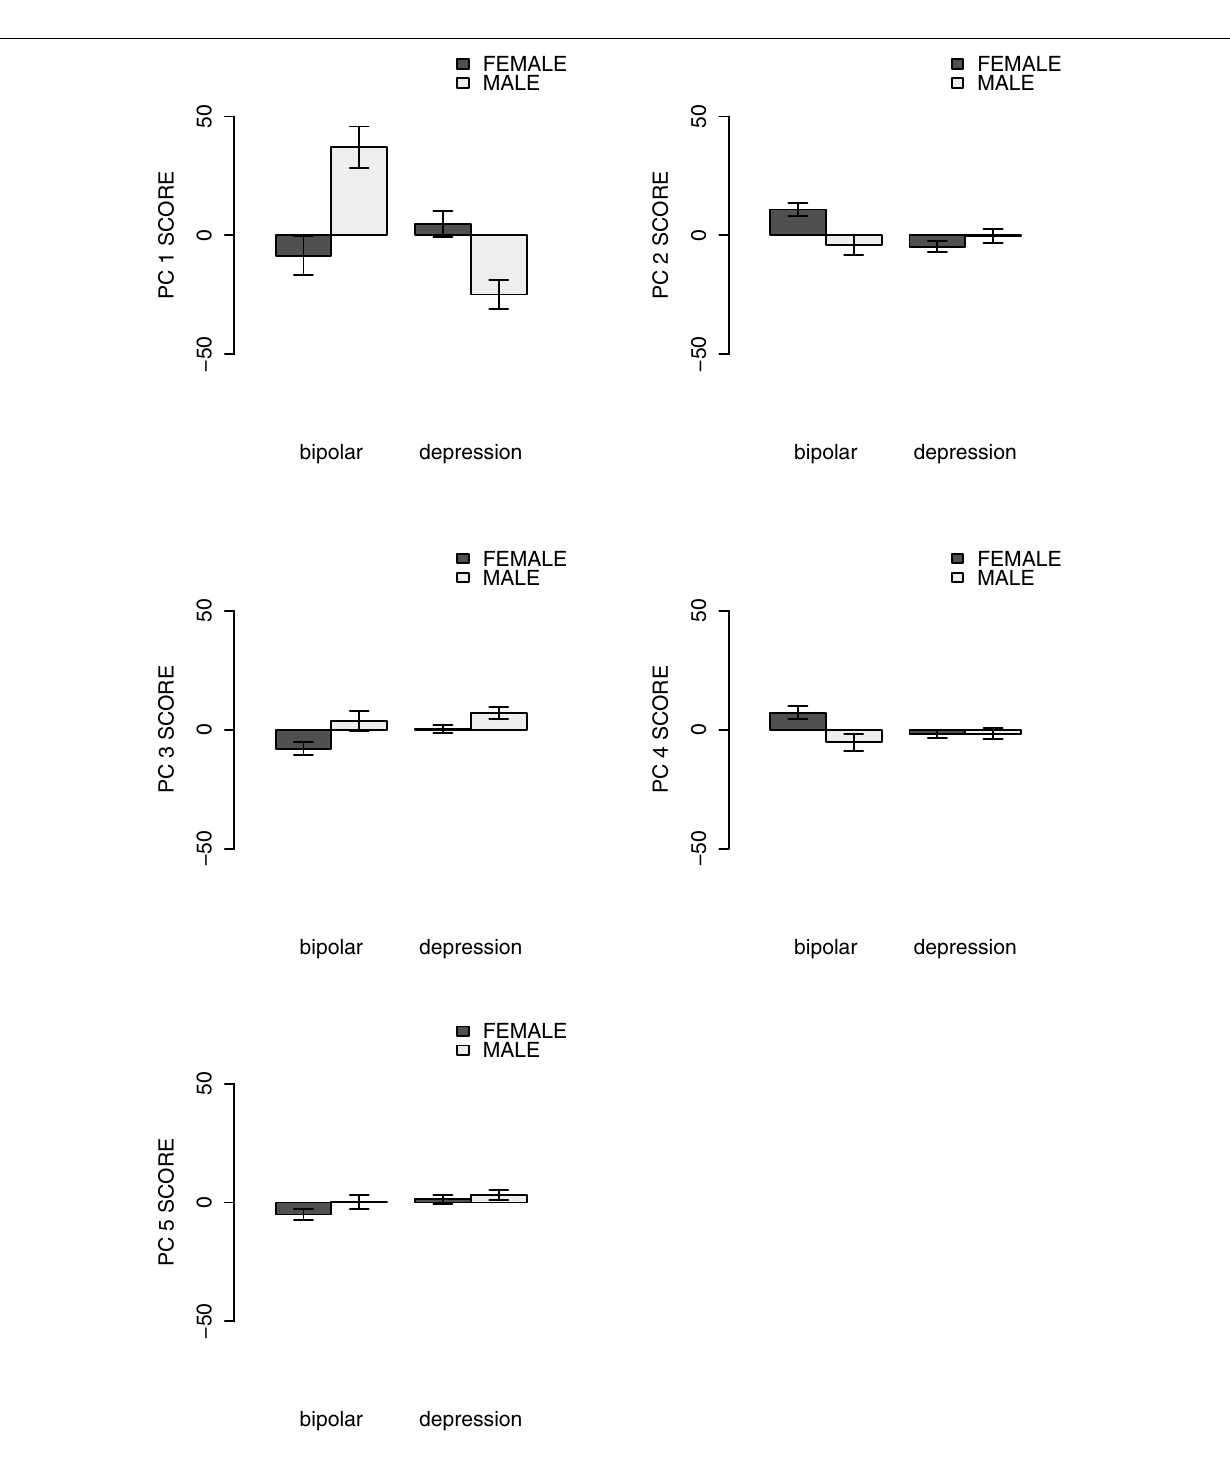
The main effect of the pathology group on the 1st PC score was insignificant [ F (1,1969) = 2.022, p = 0.155, η 2 = 0.001]. According to Figure 3 , the 1st PC was related to the total level of activity.